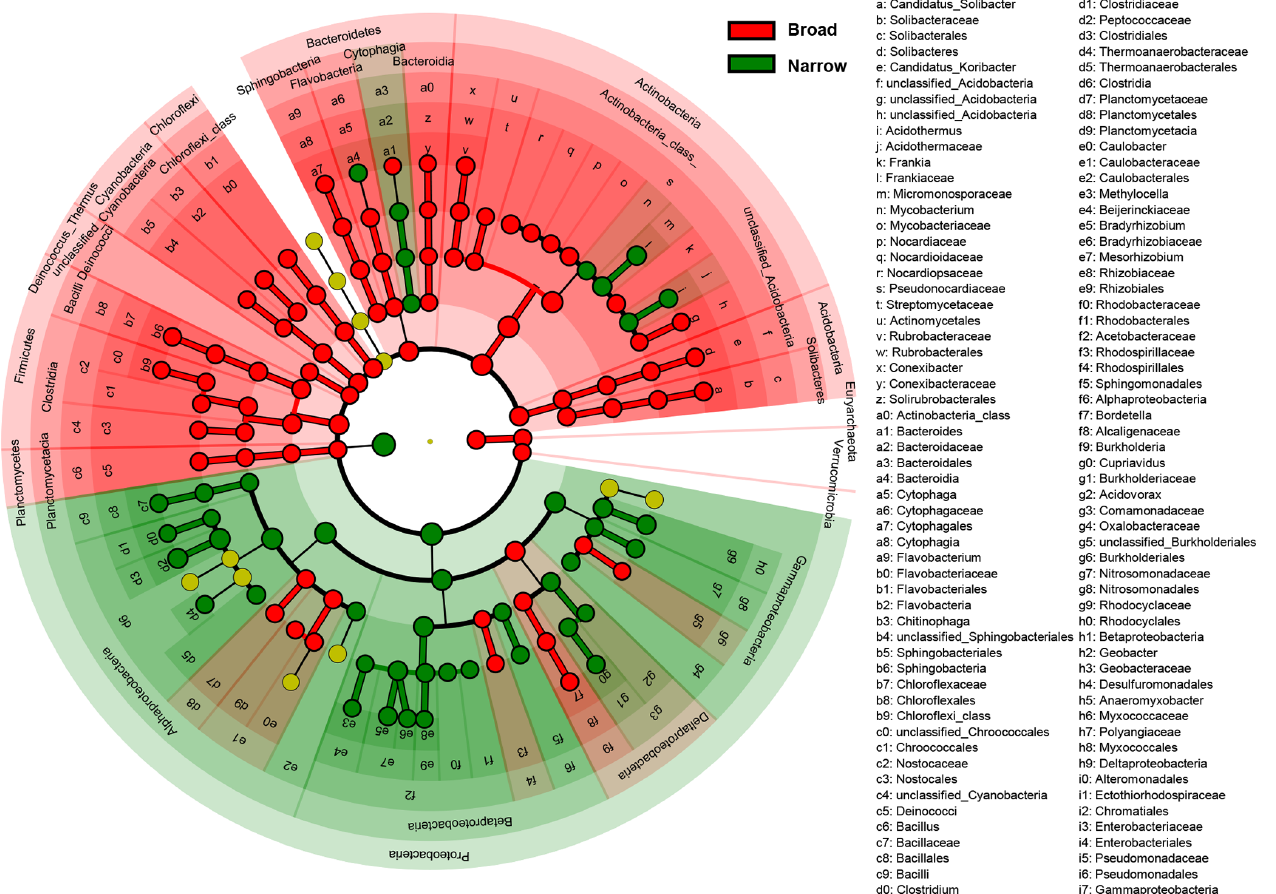
Figure 3. Difference in taxonomic compositions between broad and narrow functions. LEfSe (linear discriminant analysis effect size) results are presented that show the significant differences in the relative abundances of dominant microbial taxonomic groups (mean > 0 . 5%) between broad (red) and narrow (green) functions annotated using RefSeq (taxonomy). From the center outward, each circle represents the domain, phylum, class, order, family, and genus level, respectively. The taxonomic groups with significant differences are labeled by color.